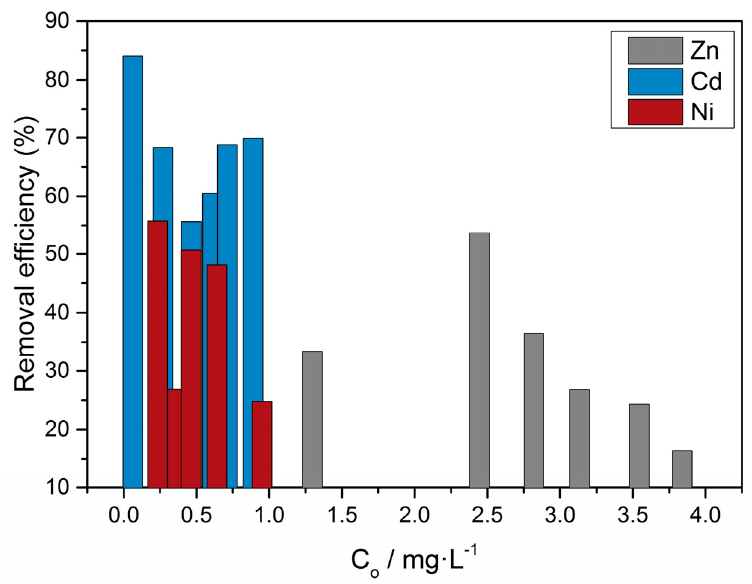
Figure 17. Removal efficiency from calcite suspensions in aqueous solutions of zinc, nickel and cadmium; 0.15 M of NaC1, pH 8.5, 25 °C.